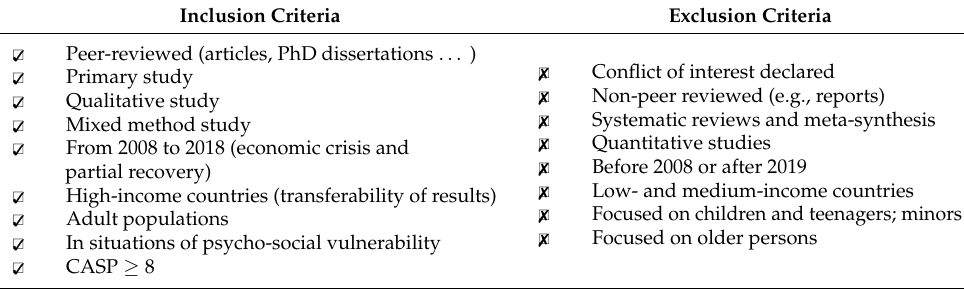
Table 1. Inclusion and exclusion